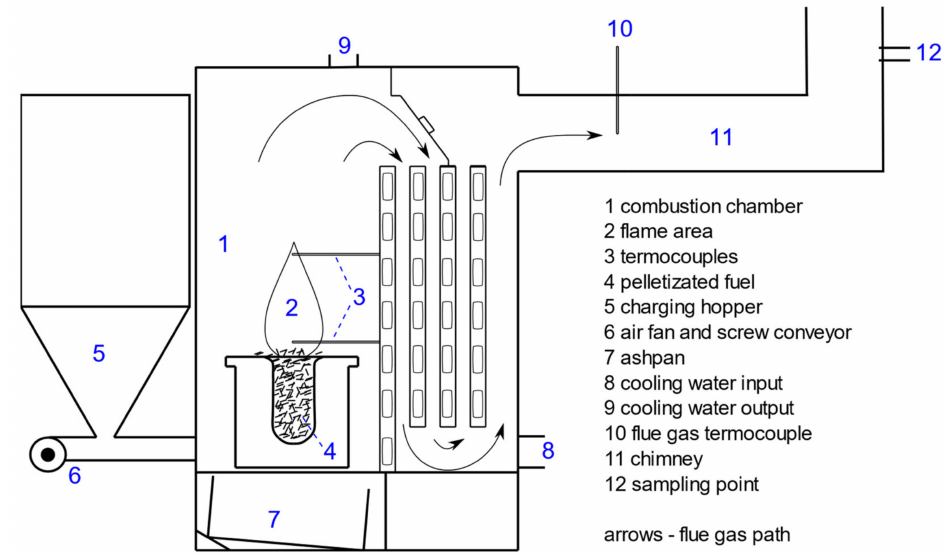
Figure 1. Schematic diagram of the boiler, thermocouples, and sampling